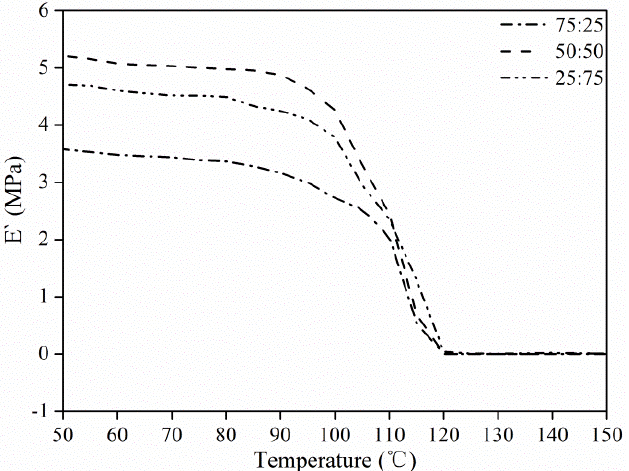
Figure 10. Dynamic mechanical analyzer (DMA) curves of electrospun PS nanofibrous